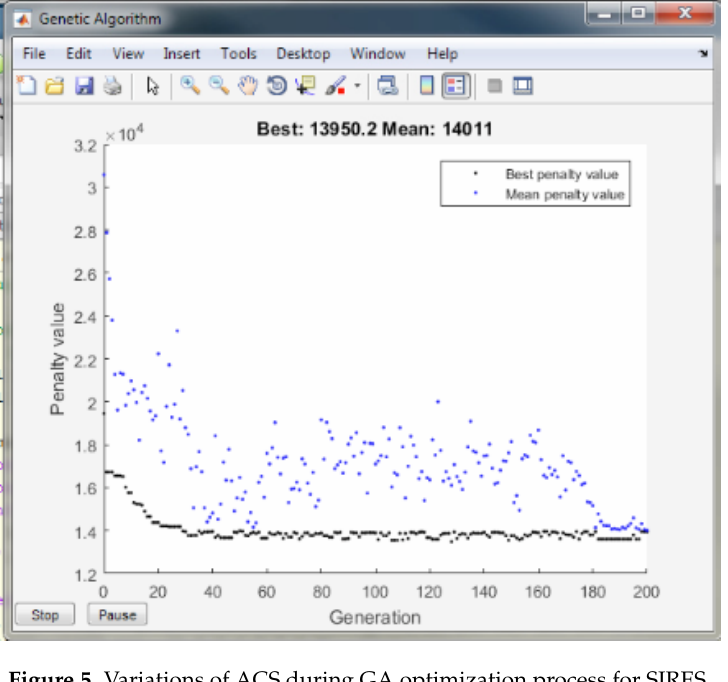
Figure 5. Variations of ACS during GA optimization process for SIRES.